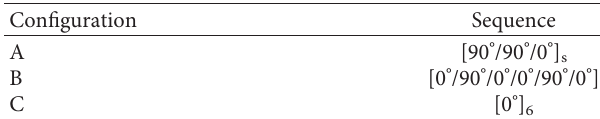
Figure 26: Amplitude versus dumping coefficient with different ply sequences ( σ � 2, L/d � 10, case I). Table 3: Configuration of